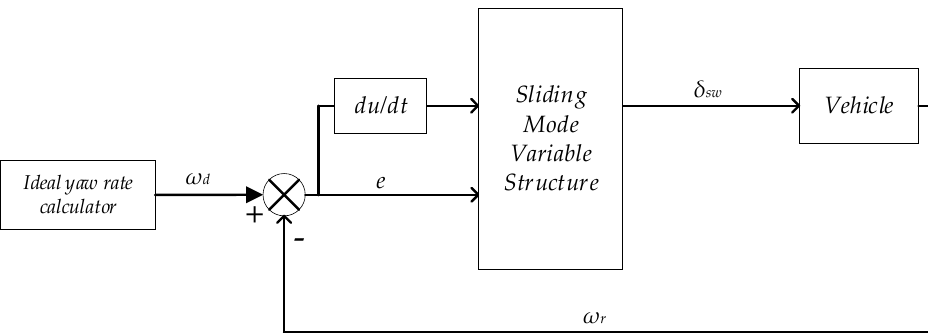
Figure 3. Controller design diagram.